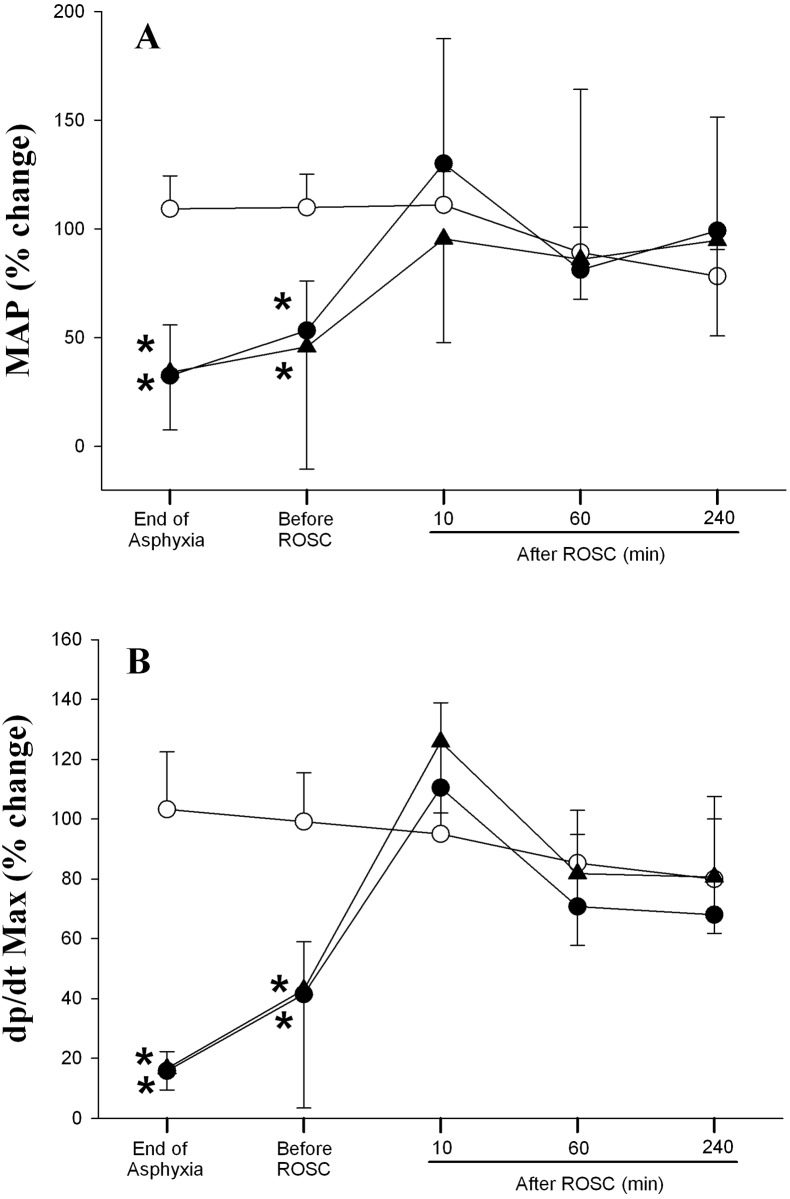
Percent changes from normoxic baseline in (A) mean arterial pressure (MAP), and (B) dp/dt max in sham (◯), SI+CC 90 (●), and SI+CC 120 (▴) groups during and after resuscitation.Each point represents mean±SD. *Significantly different from sham-operated group, p<0.05 (Tukey).